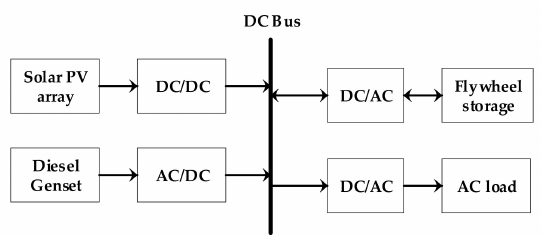
Figure 7. General configuration of a PV, DGen, and FESS connected to a load via the DC bus.